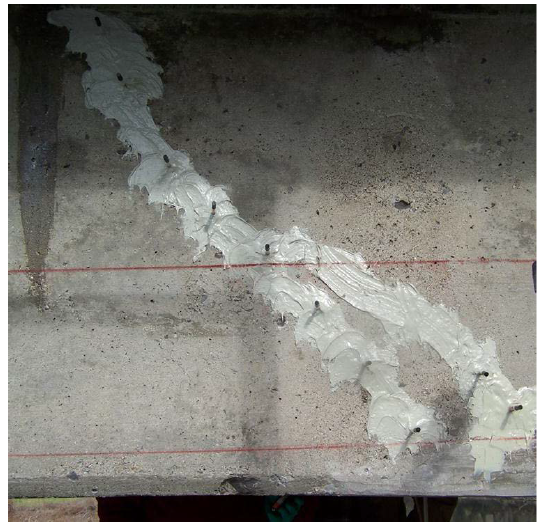
Figure 4. Example of RC girder crack filled with low-viscosity epoxy [63].